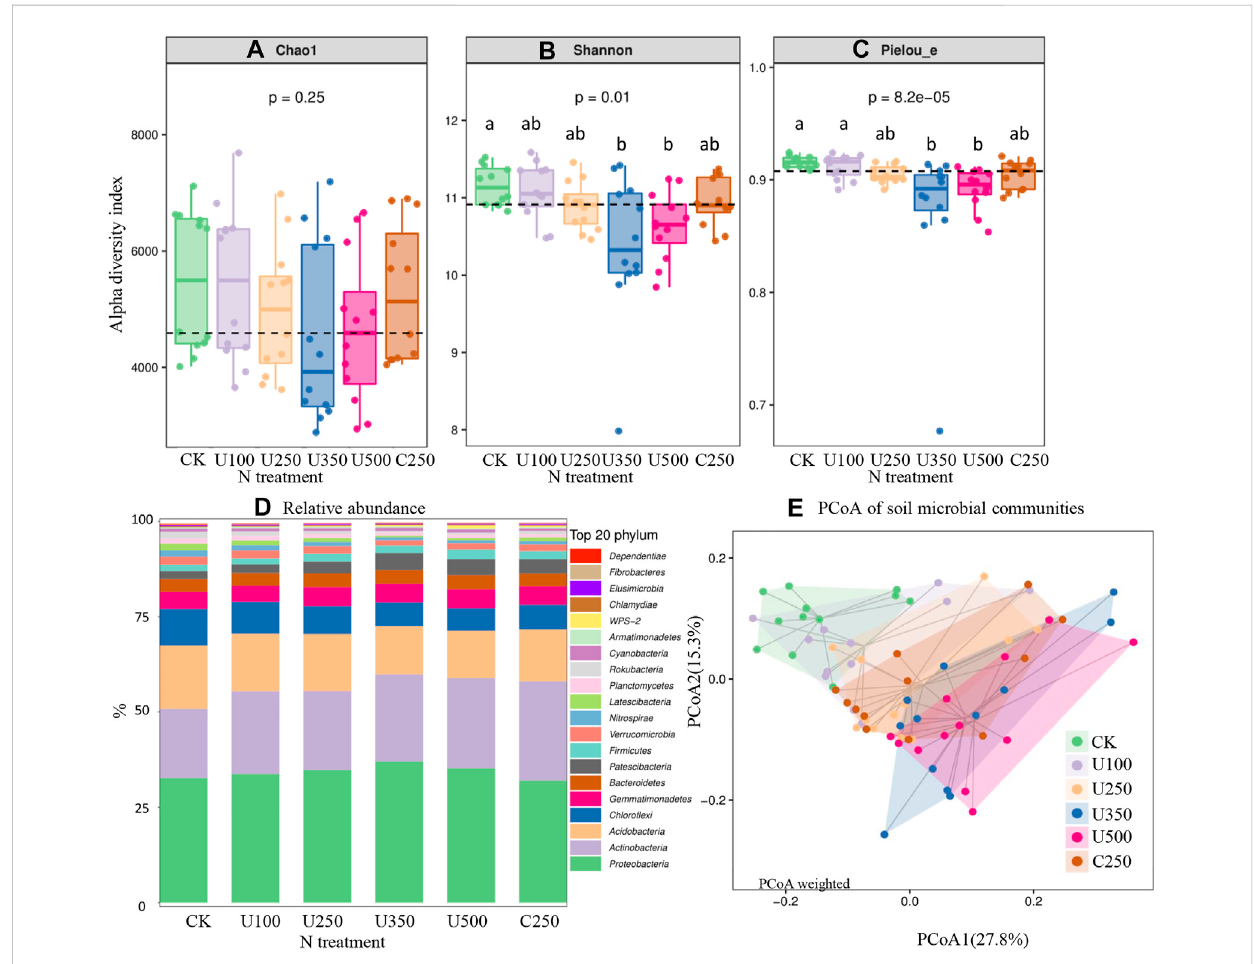
FIGURE 3 The effects of N application on soil alpha diversity index of Chao (A) , Shannon (B) , and Pielou_e (C) , relative abundance (D) , and PCoA of soil microbial communities (E) .